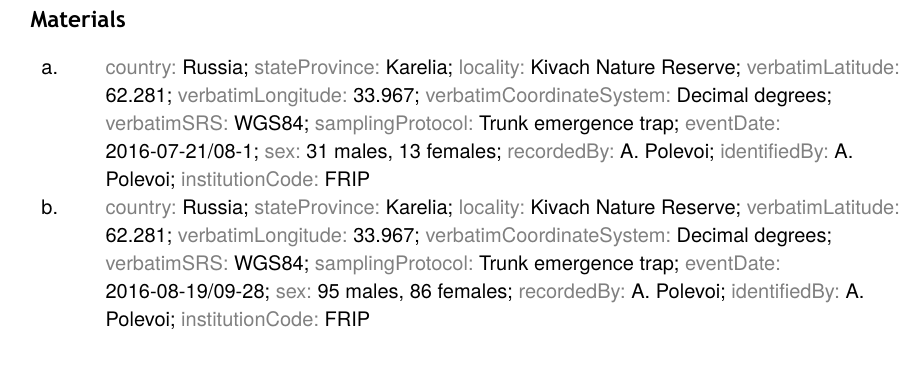
Distribution Palaearctic (Oosterbroek 2017). Karelian record is the northernmost one. Closest locations are in Poland, Lithuania and the Republic of Bashkortostan in Russia. Ecology Poorly known, though associations with dead wood and wood-destroying fungi were reported (Šev č ík 2006, Wiedenska 2007). This species was collected from a windthrown aspen, colonised by 15 species of macrofungi (Table 1).